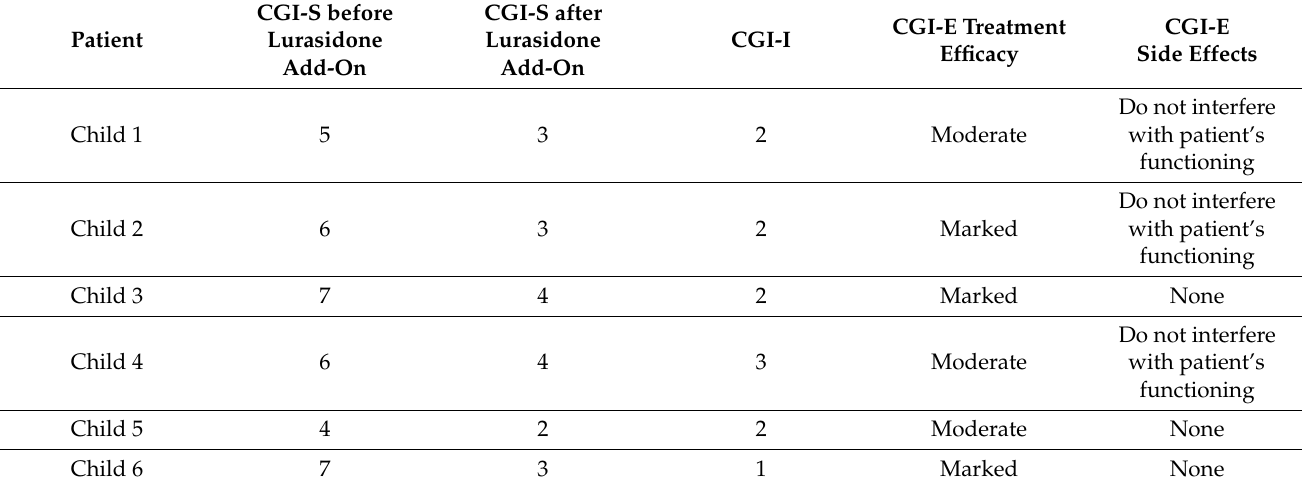
Table 2. Clinical Global Impression